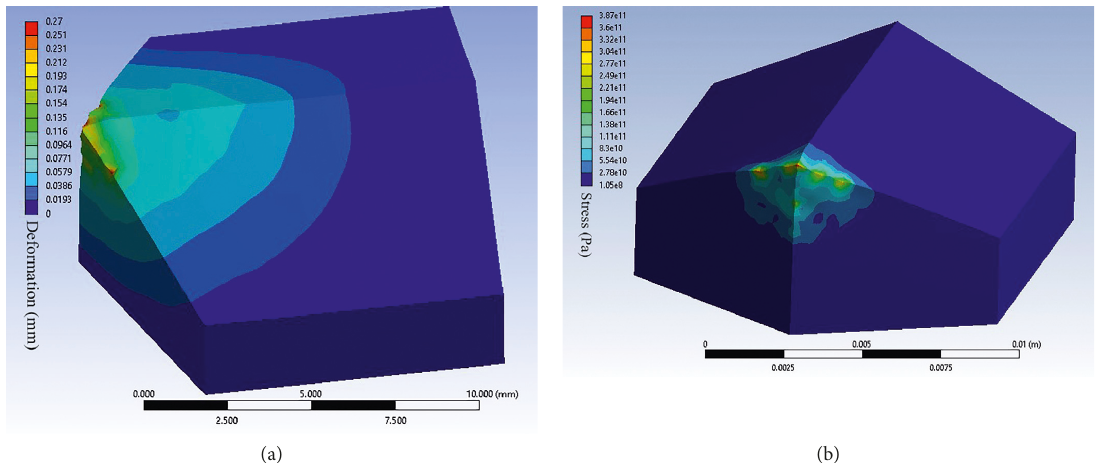
Figure 14: Deformation (a) and Von Mises stress distribution (b) of solid diamond insert.